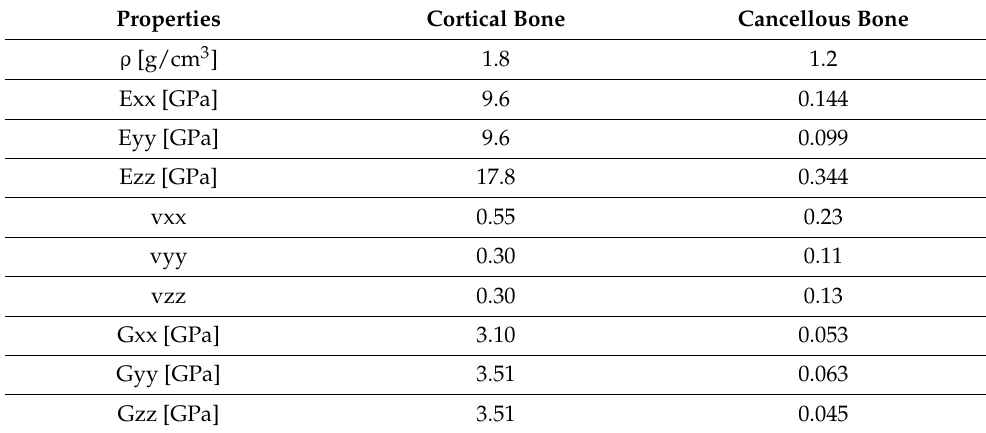
Table 1. Material properties according to the literature (CCBY 4.0)